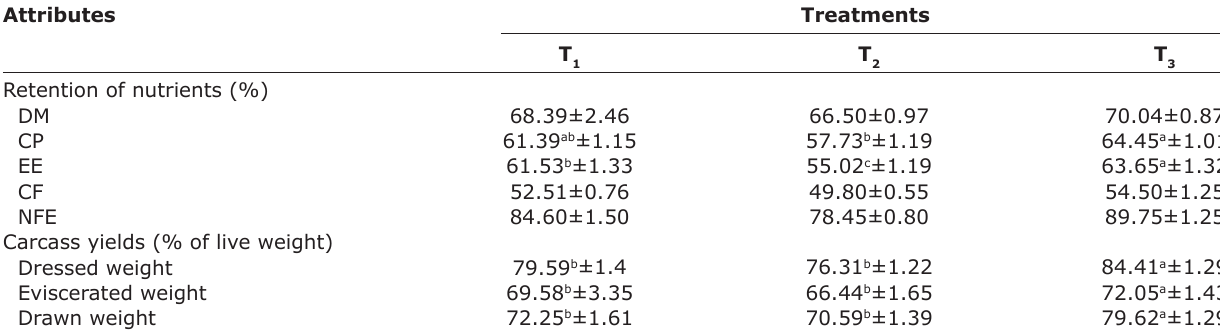
Table-3: Retention of nutrients (%) and carcass yields (% of live weight) in broilers as influenced by multicarbohydrases supplementation (0-6 weeks).